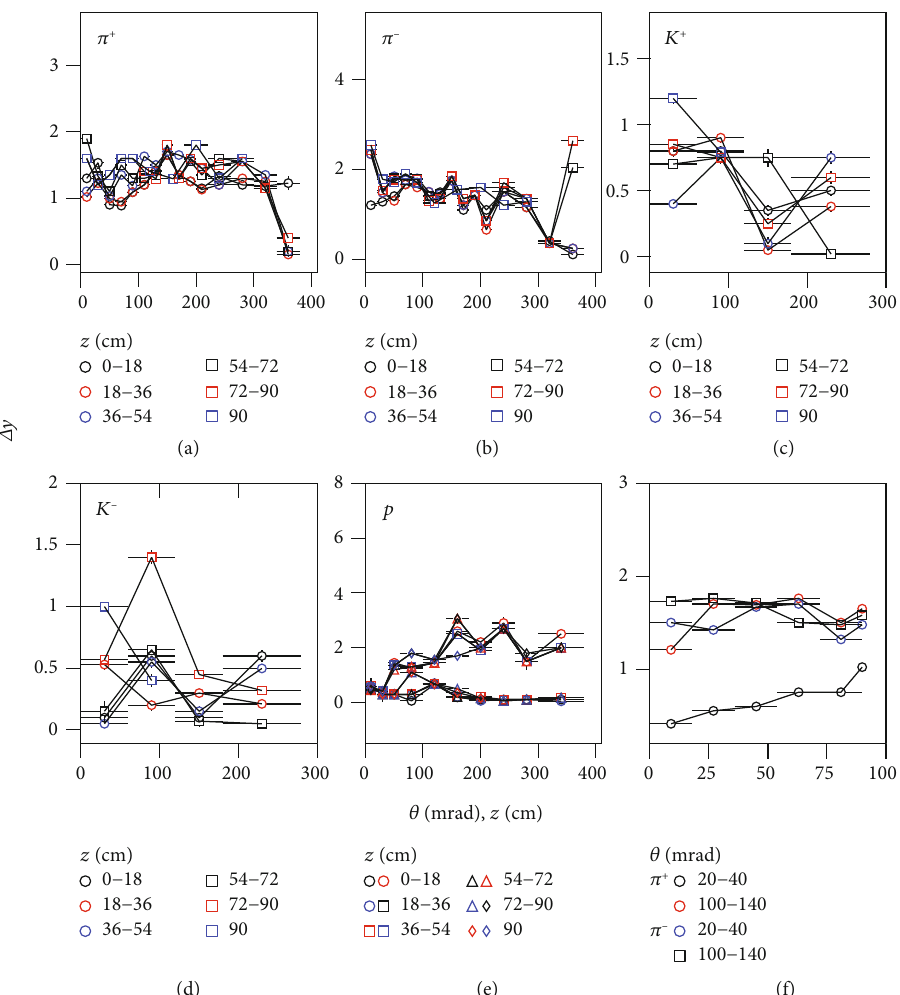
− y > 1 Þ in panel (e) represents mainly the rapidity L max L min